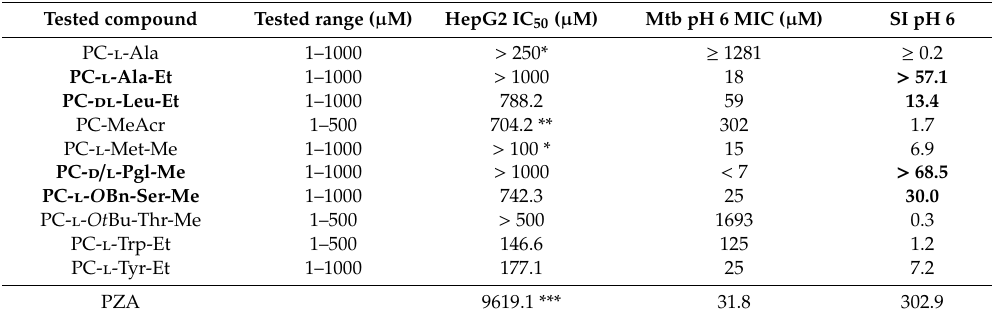
Table 4. Calculated selectivity index (SI) of the most active compounds against Mtb at pH 6 and pH 6.6. The compounds with a good cytotoxicity profile (SI > 10) are in